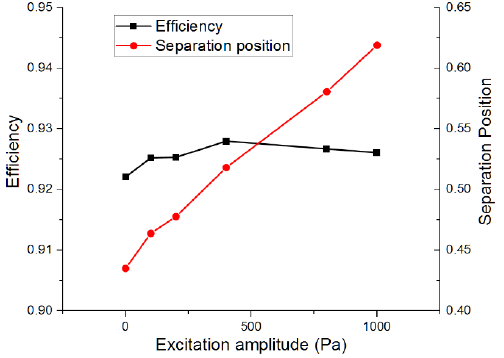
ffi ciency and separation